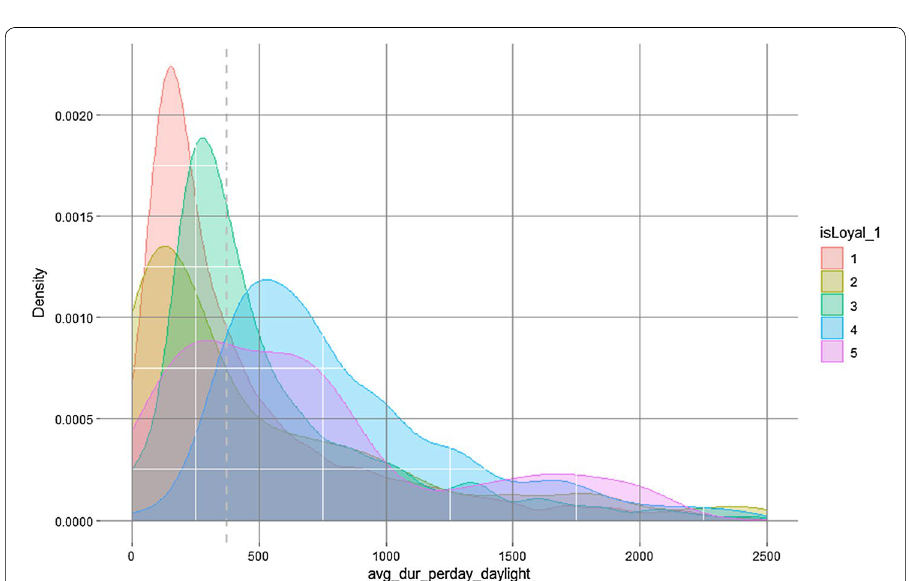
Fig. 5 Mass distribution for “Avg dur per day